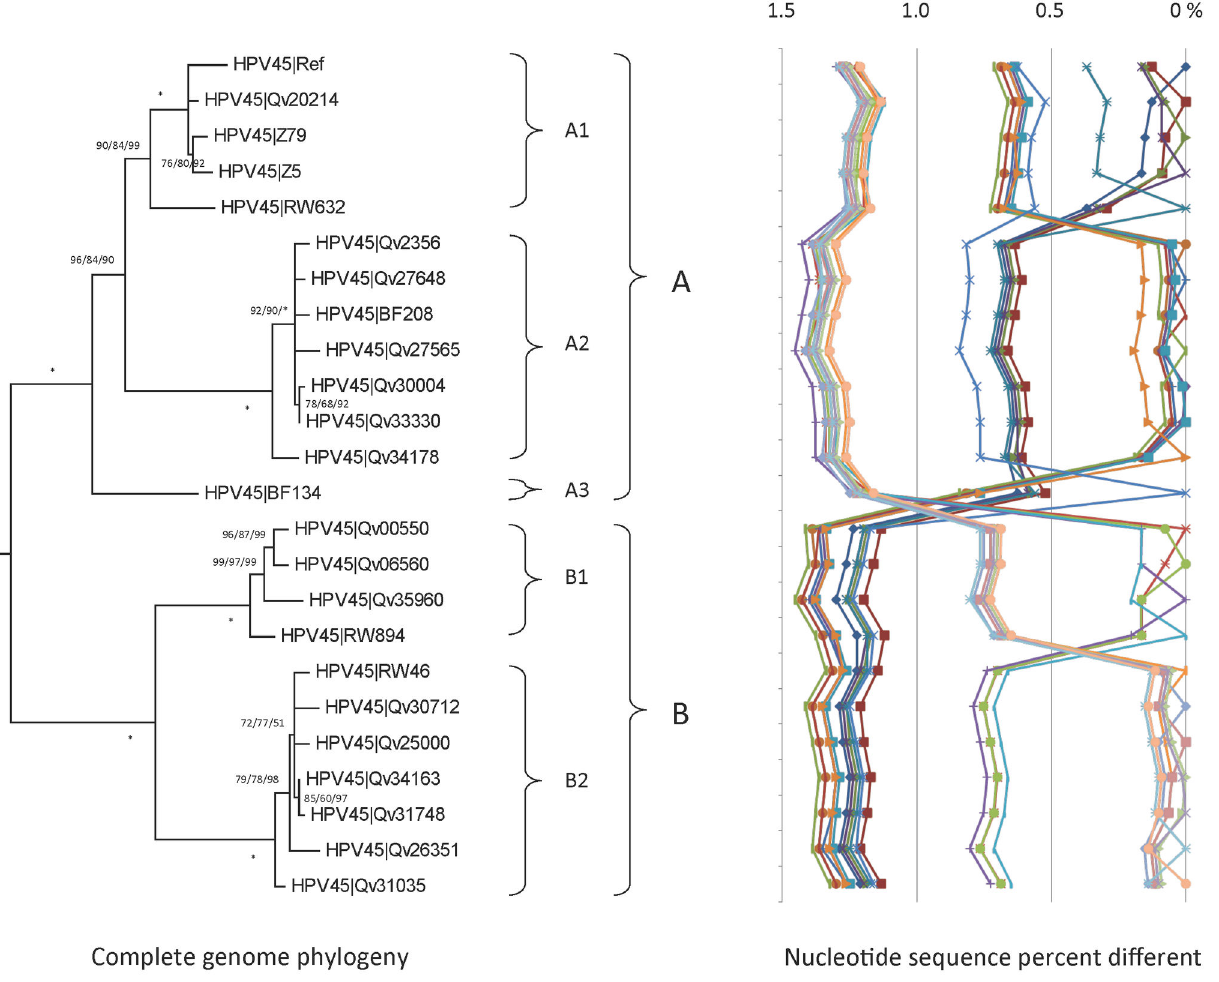
Figure 4. HPV45 variant tree topology and pairwise comparisons of individual complete genomes. The phylogenetic tree was constructed as described in Figure 2. Distinct variant lineages and sublineages were determined as described in Figure 2. The percent nucleotide sequence differences are shown in the panel to the right of the phylogenetic tree as described in Figure 2. doi: